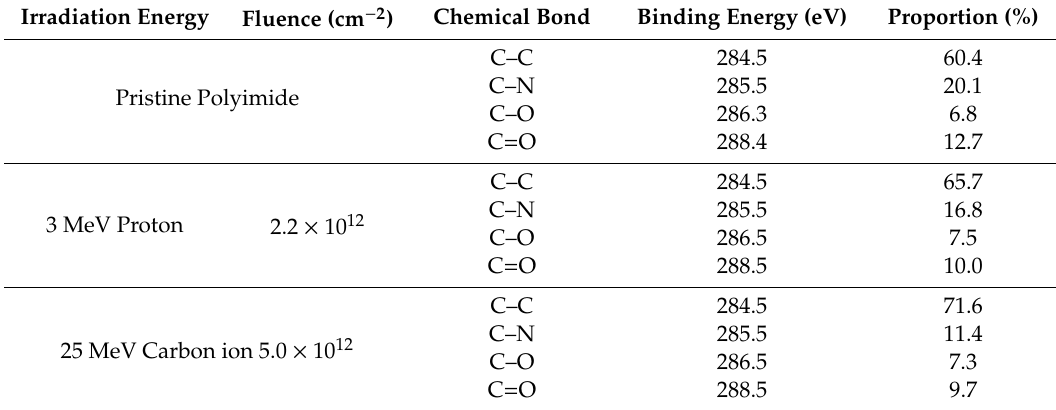
Table 1. C element composition of PI with irradiation energy of 3 MeV proton and 25 MeV carbon ion.